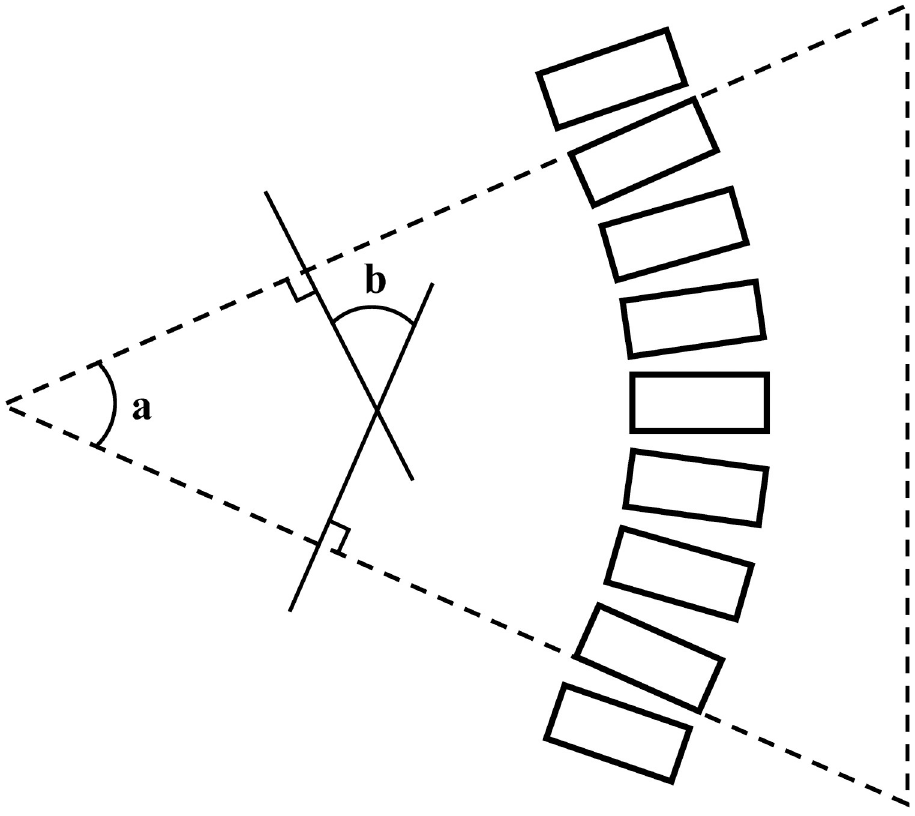
Fig 2. Schematic illustration of Cobb angle